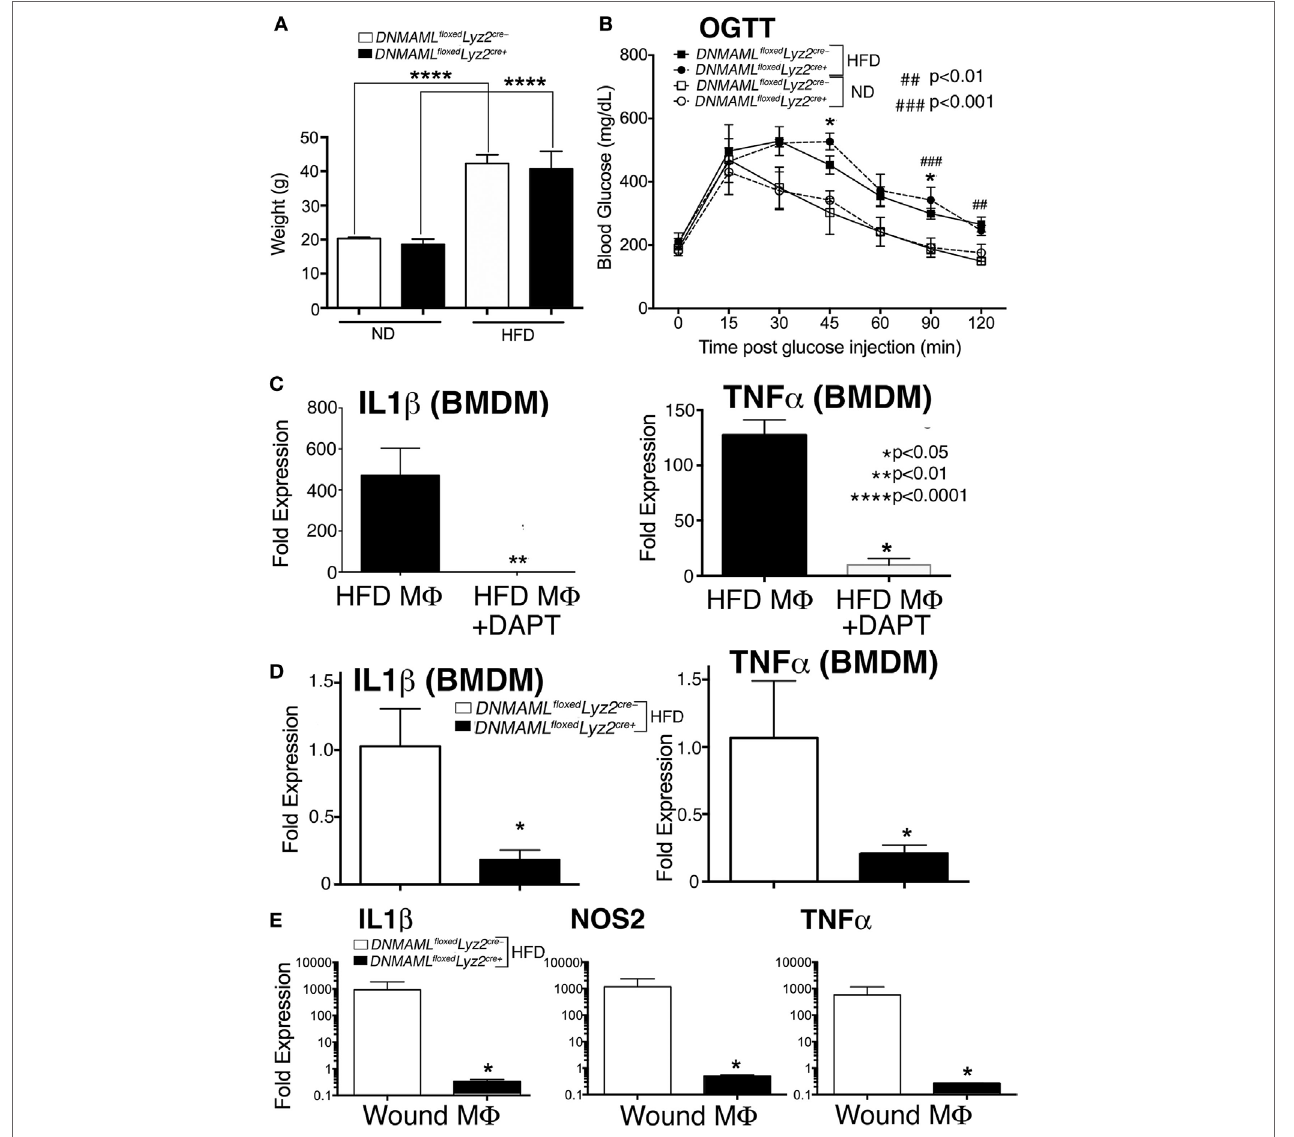
FigUre 6 | notch signaling-deficient mice on a high-fat diet (hFD) (hFD DNMAML floxed Lyz2 Cre + ) develop obesity and insulin resistance and in vitro and in vivo macrophages demonstrate decreased inflammation . DNMAML floxed Lyz2 Cre + and littermate control mice were fed either normal diet (ND) (12% saturated fat) or a HFD (60% saturated fat) for 12–14 weeks. (a) Weight (grams) of DNMAML floxed Lyz2 Cre + and littermate control mice were obtained following 14 weeks of HFD (